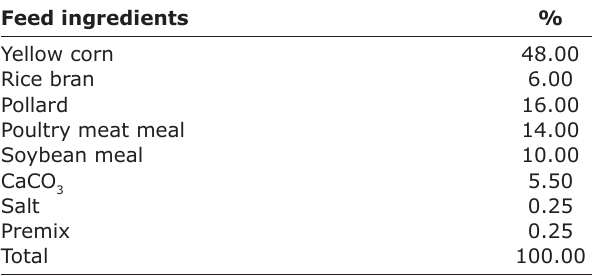
Table-1: Feed composition of the control ration. Feed ingredients Yellow corn